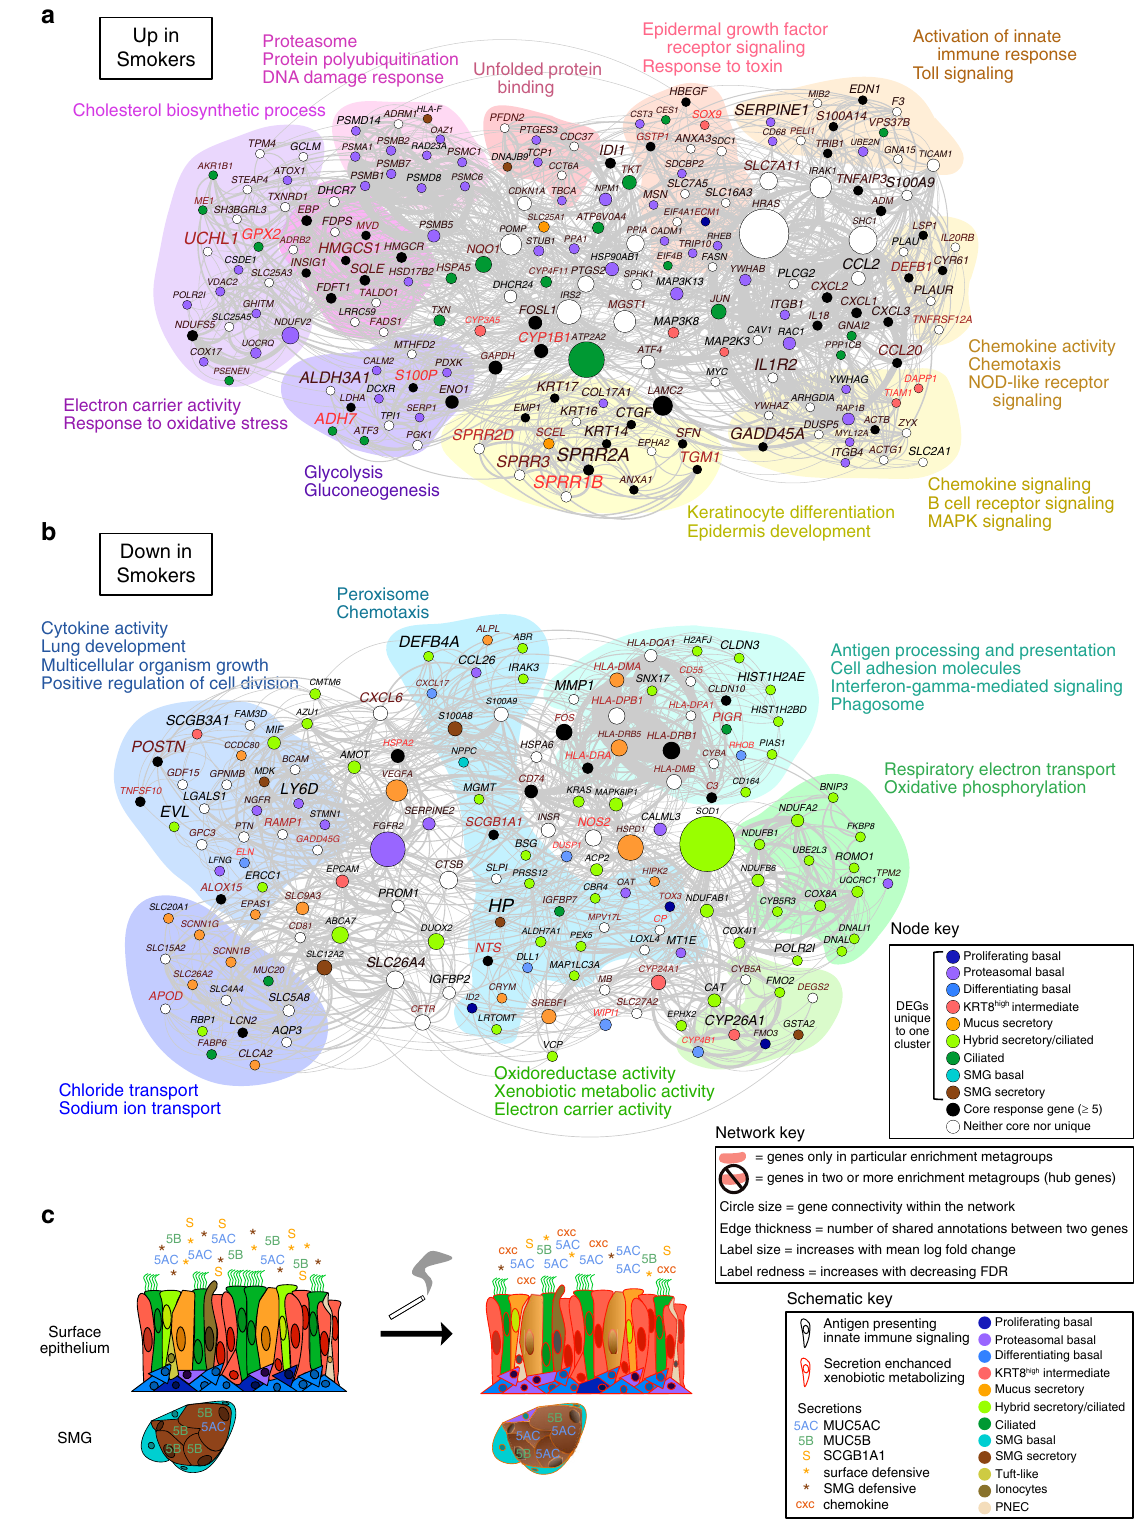
reducing the percent mitochondrial reads cutoff to 30%), which left us with 36,248 epithelial cells for further analysis. To account for differences in coverage across cells, before downstream analysis we normalized and variance stabilized UMI counts for each donor using SCTransform 69 , which yields Pearson residuals from a generalized linear model that includes sequence depth as a covariate. The Seurat R package 70 was used to carry out all data normalization and scaling as well as downstream batch